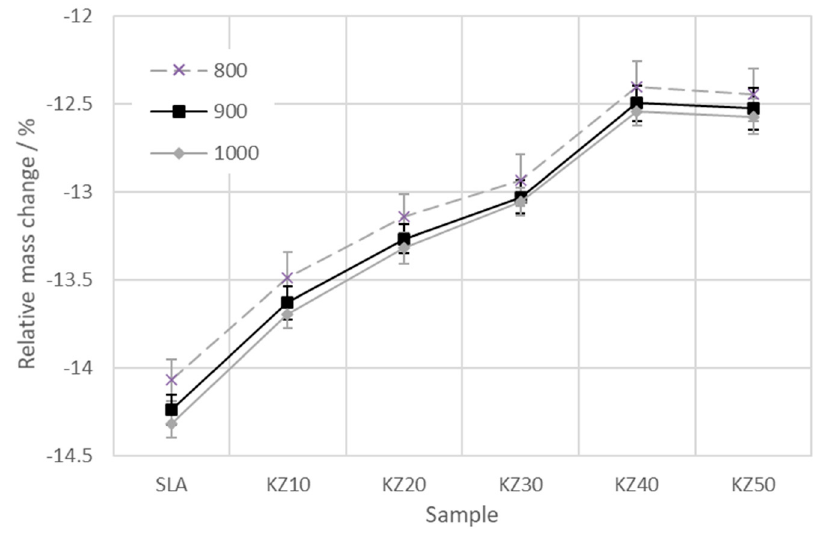
Figure 5. Relative mass change of the studied samples at 800, 900, and 1000 °C.